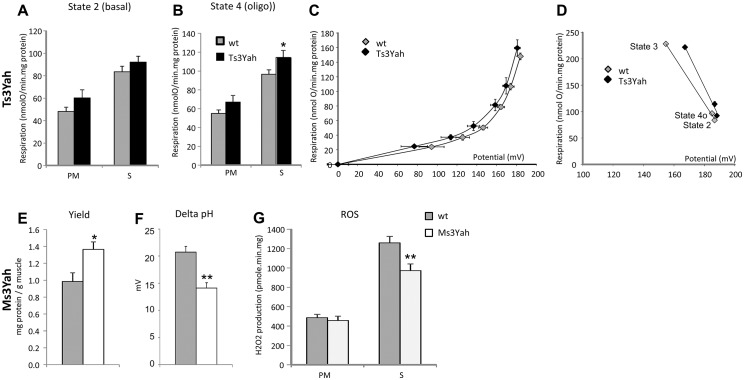
Evaluation of mitochondrial function.Mitochondria were isolated from hind limb muscle to test their respiration capacities. (A) Yield of mitochondrial protein per gram of muscle obtained from the mitochondrial extraction. (B–D) The rates of oxygen consumptions were measured in isolated muscle mitochondria in the presence of pyruvate/malate (PM) or succinate (S) as described in Materials and Methods. (B) State 2, basal was measured in the presence of substrates only. (C) State 3, ADP-stimulated respiration was measured with the addition of 500 μM ADP. (D) State 4o, after addition of oligomycin. (E) COX activity was given by measuring mitochondrial oxygen consumption during PM respiration with the addition of 10 mM antimycin, 2 mM ascorbate, and 0.5 mM TMPD. (F) Basal proton leak was visualised by plotting the rate of oxygen consumed against mitochondrial membrane potential. (G) Kinetic response of substrate oxidation activity to membrane potential at states 3, 2, and 4o in Ts3Yah and diploid isolated mitochondria. Data are presented as mean ± sem (n = 5–6 per genotype) with Student’s t-test (A and G) and two-way ANOVA with all pairwise multiple comparison procedures (Holm-Sidak method) (D), *p<0.05, **p<0.01.